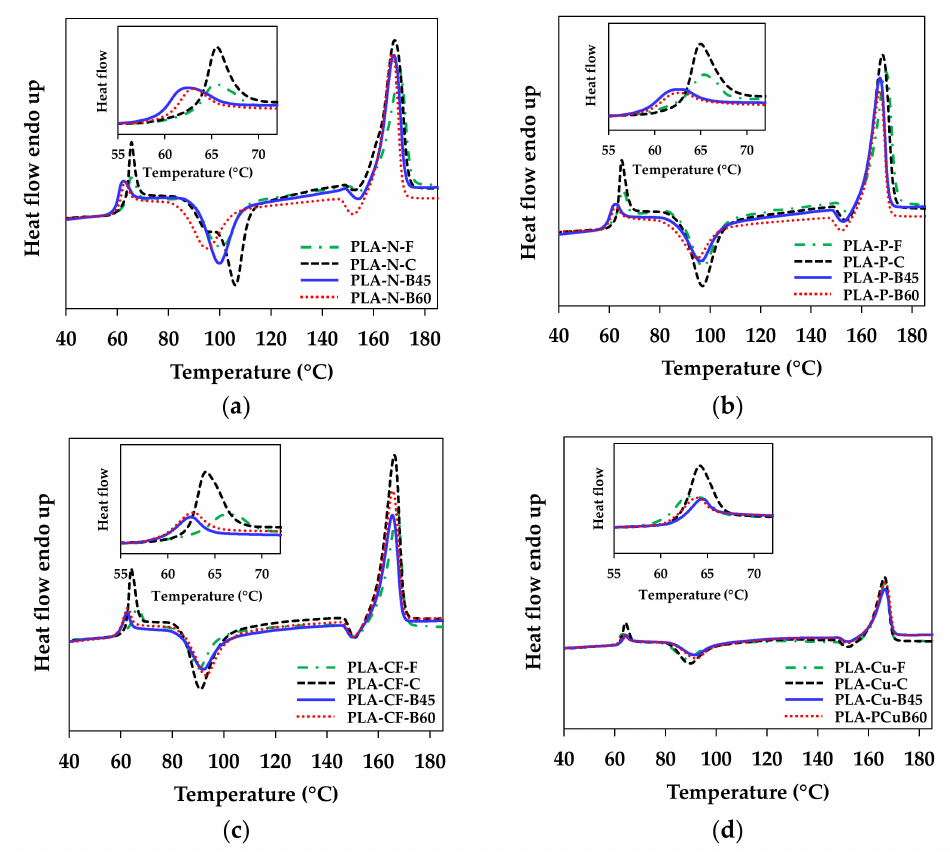
Figure 7. DSC thermograms of the first heating cycle of compression molded sheet and 3D printed samples: ( a ) PLA-N; ( b ) PLA-P; ( c ) PLA-CF; and ( d )